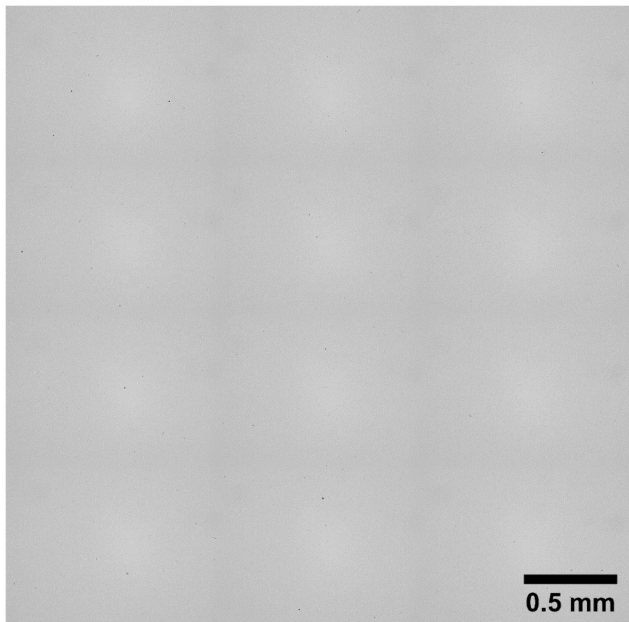
Figure A5. Large-scale (around 3.3 mm × 3.3 mm square) optical micrograph of the MAD542 superalloy heat treated at 1230 ◦ C for 2 h (sample preparation: metallographic polishing).